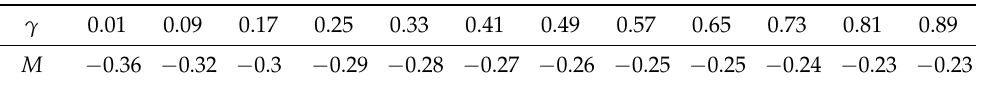
Table 2. Values of the medial correlation of the GCC copula for θ = ( − 1/ γ , values of γ , belonging to Configuration 2.